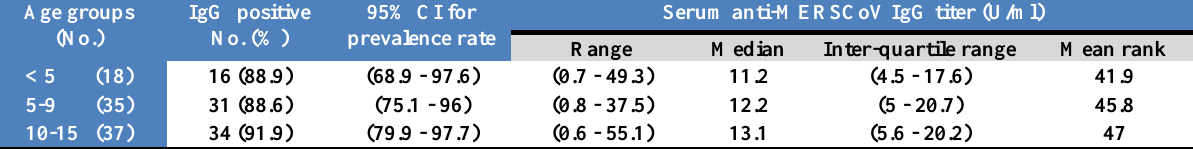
Table, 2: The anti-MERS-CoV IgG positivity rate and titer according to age groups. Age groups (No.)